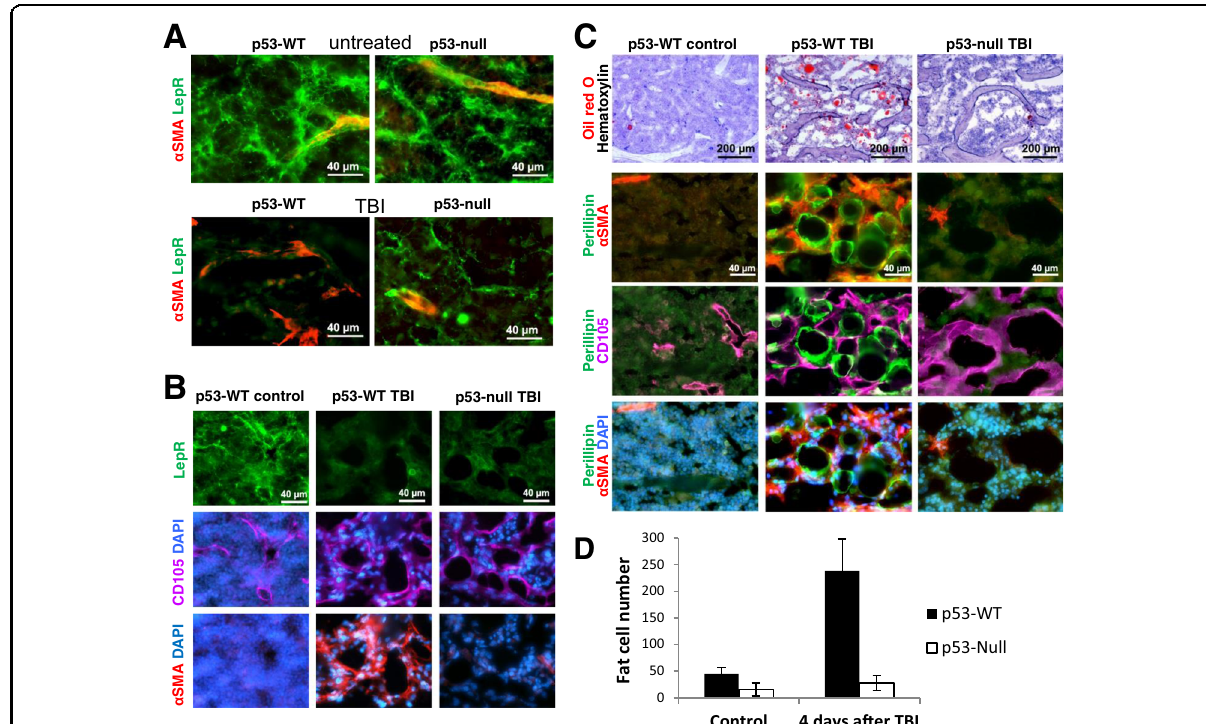
Fig. 4 IR induces adipocyte differentiation in the BM of p53-WT mice but not p53-null mice. A Longitudinal sections of femoral BM (distal metaphysis) were prepared from control (non-irradiated) and irradiated (13 Gy) p53-WT and p53-null mice 24 h after IR and stained for LepR and α SMA expression. B Longitudinal sections of femoral BM (distal metaphysis) were prepared from control (non-irradiated) p53-WT mouse and from irradiated (11 Gy) p53-WT and p53-null mice 4 days after IR and stained for LepR, α SMA, and CD105 expression. DAPI was used as a costain to visualize nuclei. C Longitudinal sections of femoral BM (distal metaphysis) as described in B were stained with Oil Red O and hematoxylin (upper panel) and for perilipin, CD105, α SMA, and DAPI (lower panels). D Quantitation for Oil Red O-positive cells (in C , upper panels) in p53-WT and p53-null BM before and after TBI. Oil Red O-positive cells were counted from the images ( fi ve fi elds) taken with objective ×5. Error bars signify SEM. The difference between the number p53-null and p53-WT fat cells per counted fi eld was statistically signi fi cant ( P = 0.005 by two-tailed t